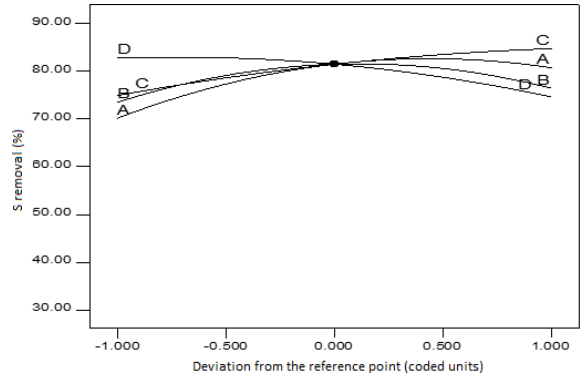
Figure 3: Plot of externally studentized residuals versus run